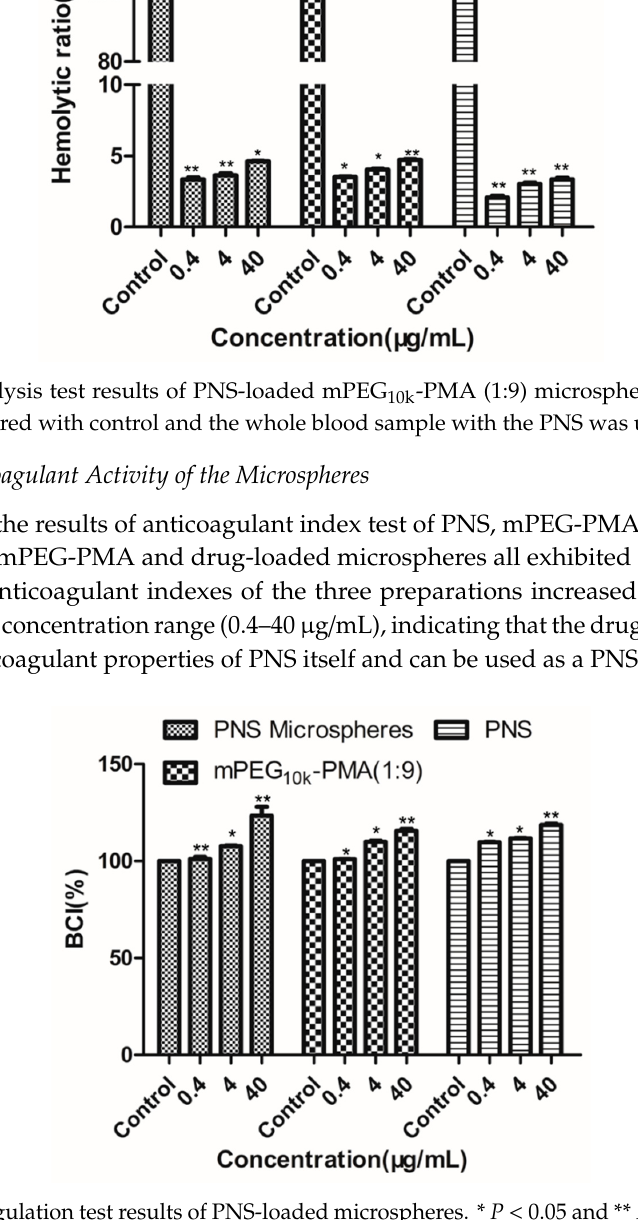
Figure 7. Anticoagulation test results of PNS-loaded microspheres. * P < 0.05 and ** P < 0.01, compared with control and the whole blood sample with the PNS was used as a control.